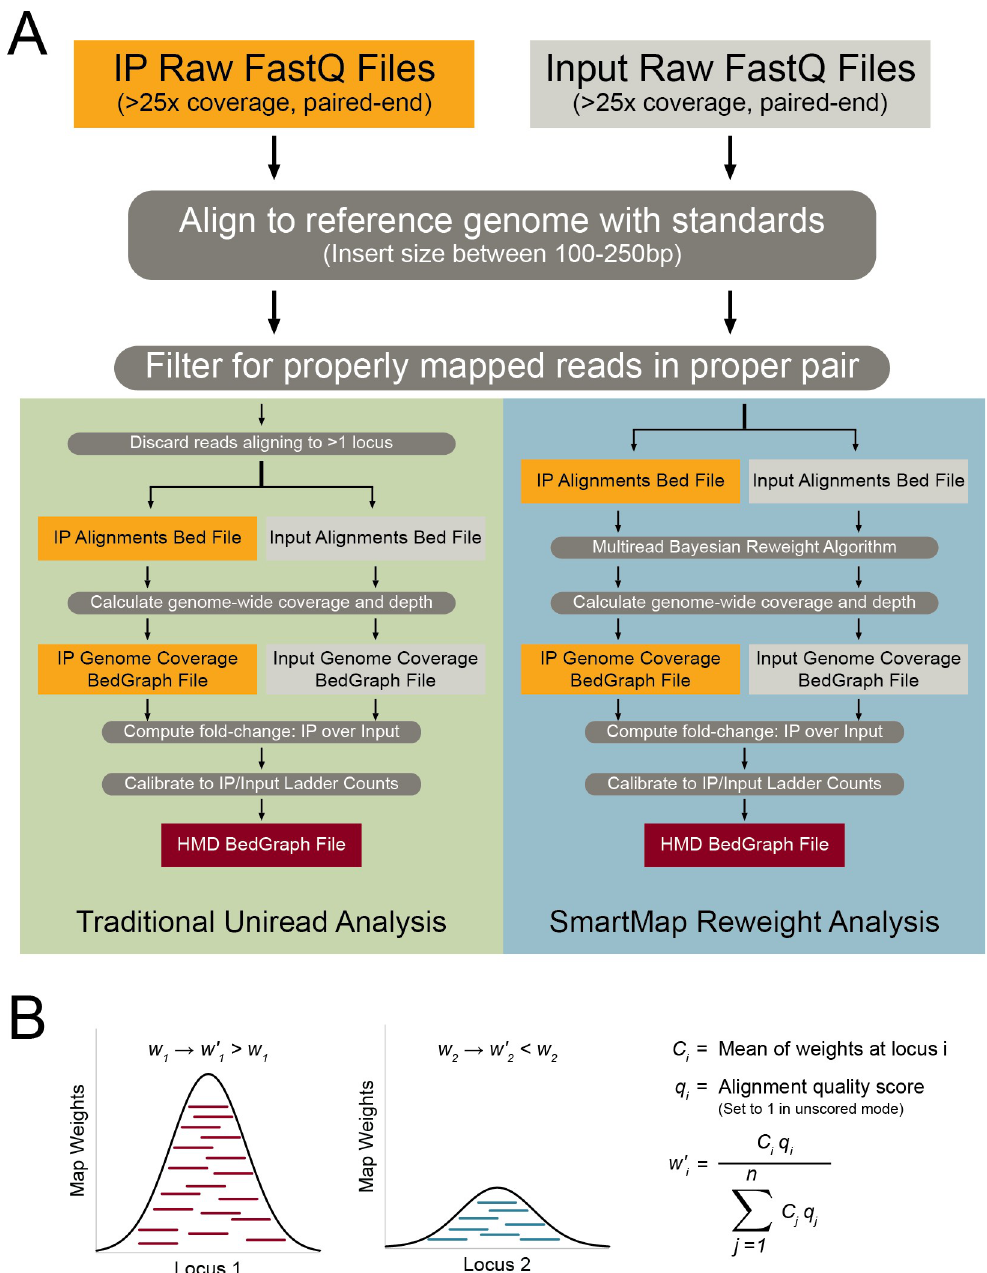
Fig 1. Summary of the SmartMap analysis workflow and algorithm. (A) Flowchart outlining the workflow for traditional ChIP-seq (or ICeChIP-seq) analysis [29–31] utilizing only unireads (left, green) vs. the workflow for SmartMap analysis utilizing multireads with an iterative Bayesian reweighting algorithm (right, blue). (B) Schematic showing the Bayesian reweighting algorithm utilized in the SmartMap analysis. Each mapping associated with a read is assigned a weight such that the weight is greater for those mappings associated with loci of greater map weight density. For more detailed description of the algorithm, see